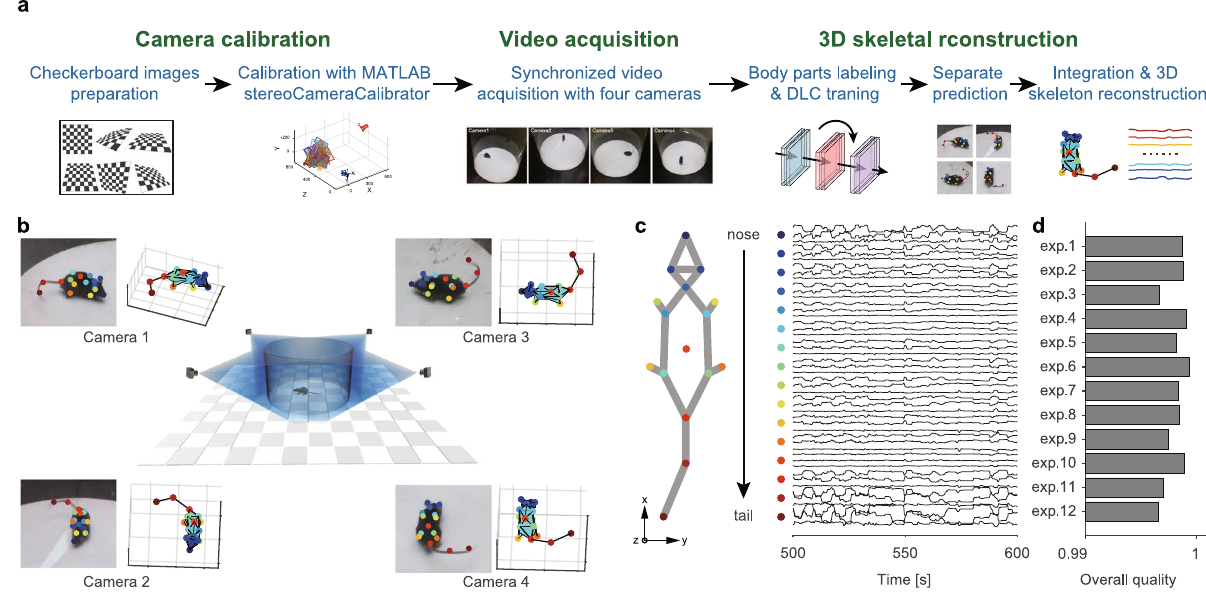
Fig. 2 Collecting animal behavior trajectories via a 3D motion-capture system. a Pipeline of 3D animal skeletal reconstruction. b Center, schematic diagram of recording animal behavior with four synchronized cameras; corners, frames captured by the cameras with the DLC labels (left) and the corresponding reconstructed skeletons (right). c Left: 16 key body parts include the nose, left ear, right ear, neck, left front limb, right front limb, left hind limb, right hind limb, left front claw, right front claw, left hind claw, right hind claw, back, root tail, middle tail, and tip tail. Right: representative mouse body tracking trace data collected over 100 s showing 48 data vectors obtained by DLC for each body part (indicated with a color-coded dot) encoded by x , y , and z coordinates. For visualization purposes, mean normalization is applied to each trace. d 3D reconstruction quality assessment: 1 — best quality, 0 — worst quality. The quality of the data obtained from the 12 mice averaged at 0.9981 ± 0.001. Source data are provided as a Source Data fi